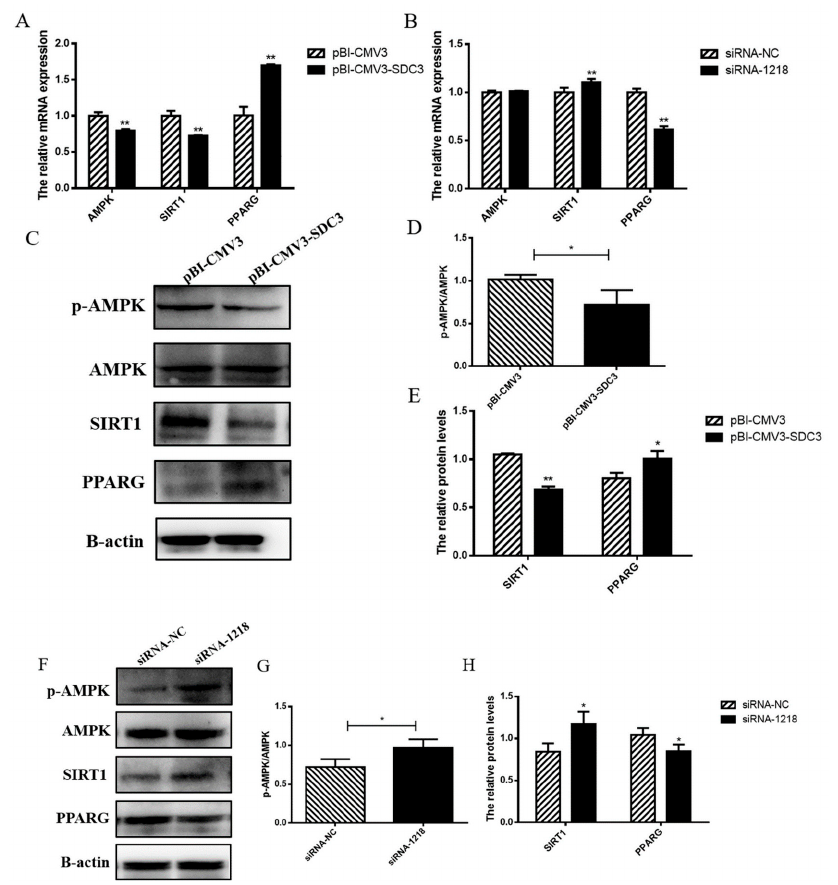
Figure 4. SDC3 regulates milk fat synthesis through the AMPK pathway. pBI-CMV3-SDC3 vector or siRNA-1218 transfected into BMECs. ( A , B ) The relative mRNA expression of AMPK, SIRT1 and PPARG in BMECs, after over-expression and knockout of SDC3 , as analyzed by RT-qPCR. ( C , F ) Western blo tt ing, used to analyze the protein expression levels of Phosphorylated AMP-activated protein kinase ( P-AMPK ), AMPK, SIRT1 , and PPARG in BMECs after overexpression and knockout of SDC3 . ( D , G ) The ratios of phosphorylated-to-total AMPK , quantified by gray scale scan. ( E , H ) Relative folds of SIRT1 and PPARG protein levels (protein/ β -actin) from Western blots, quanti- fied by gray scale scan. Data presented as means ± SD (n = 3). Statistically significant differences are indicated: * p < 0.05, ** p < 0.01. pBI-CMV3, siRNA-NC = nonspecific scrambled